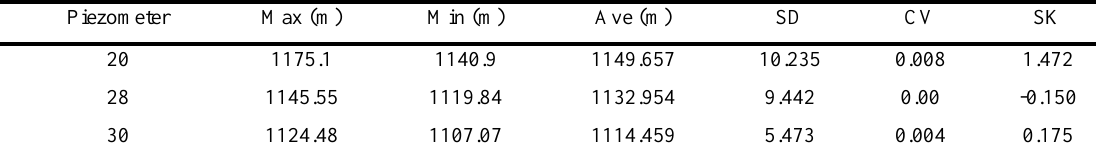
Table 1- Statistical analysis of piezometers’ water level data used in the present